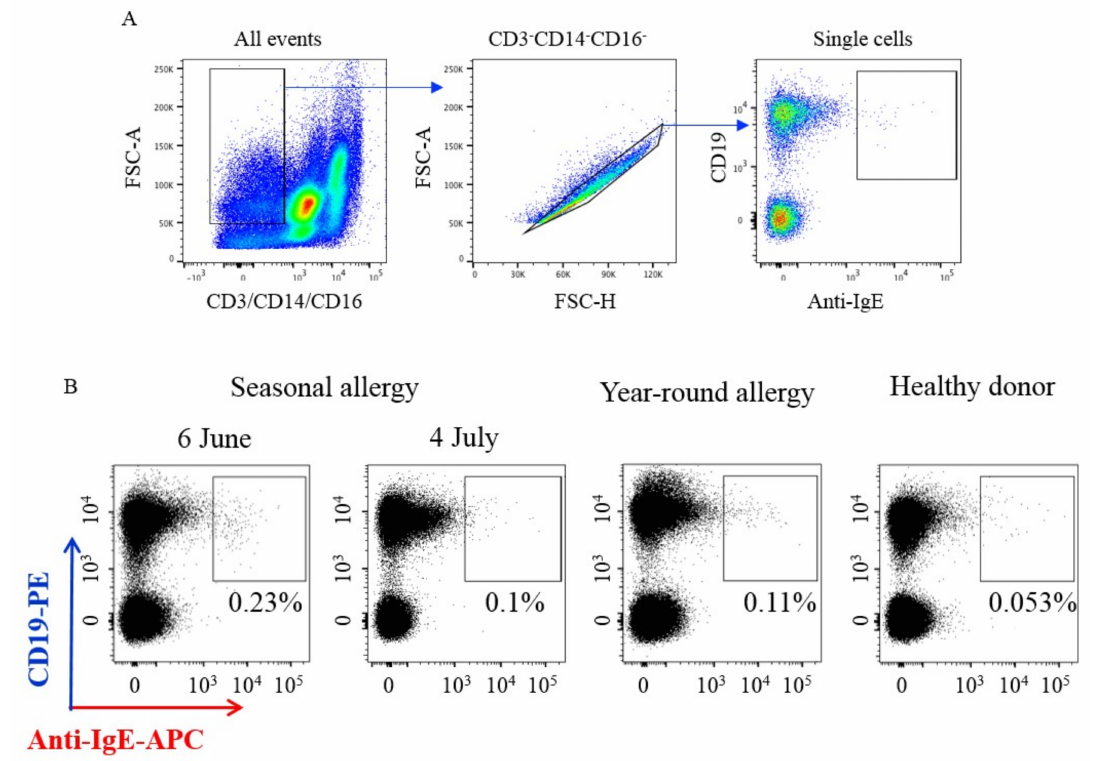
Figure 2. Isolation of IgE + B lymphocytes from PBMC of donors with di ff erent type of allergy. ( A ) Gating strategy for detection of IgE + B lymphocyte. B lymphocyte subset were gated as CD3-CD14-CD16- (FSC area / CD3, CD14, CD16), single cells (FSC area / FSC height), CD19 + , and then detection of IgE + B cells was based on surface IgE expression. ( B ) Example of di ff erent percentage of IgE + B cells in donor samples with di ff erent types of allergy. The highest percentage of IgE + cells were detected in a donor sample with seasonal allergy shortly after the pollen season (6th June) and they disappeared a month later (4th July). As a control, we used blood samples from healthy donors, as well as donors with year-round